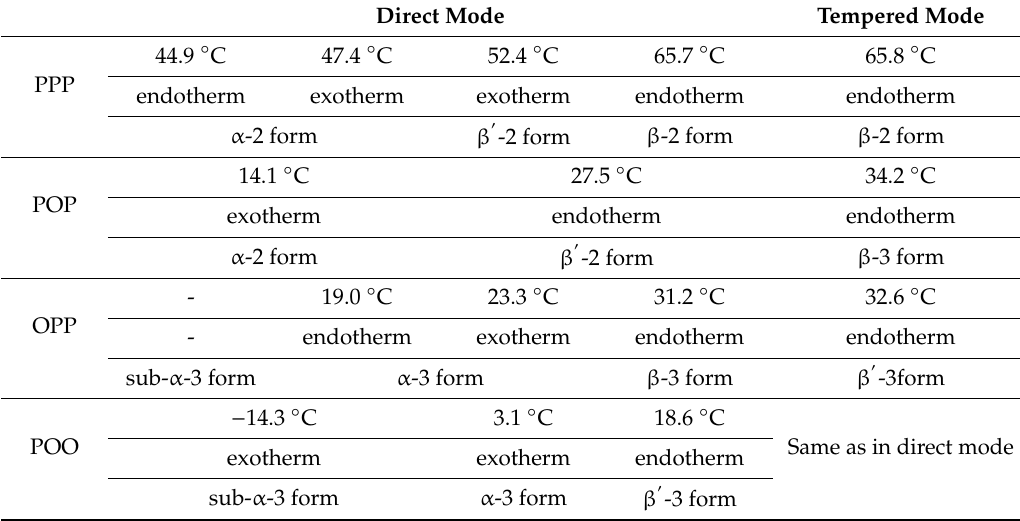
Table 2. Melting (endotherms) and transition (exotherms) temperatures and polymorphic forms in direct mode; last melting temperatures (endotherms) and polymorphic forms in tempered mode for pure PPP, POP, OPP and POO.